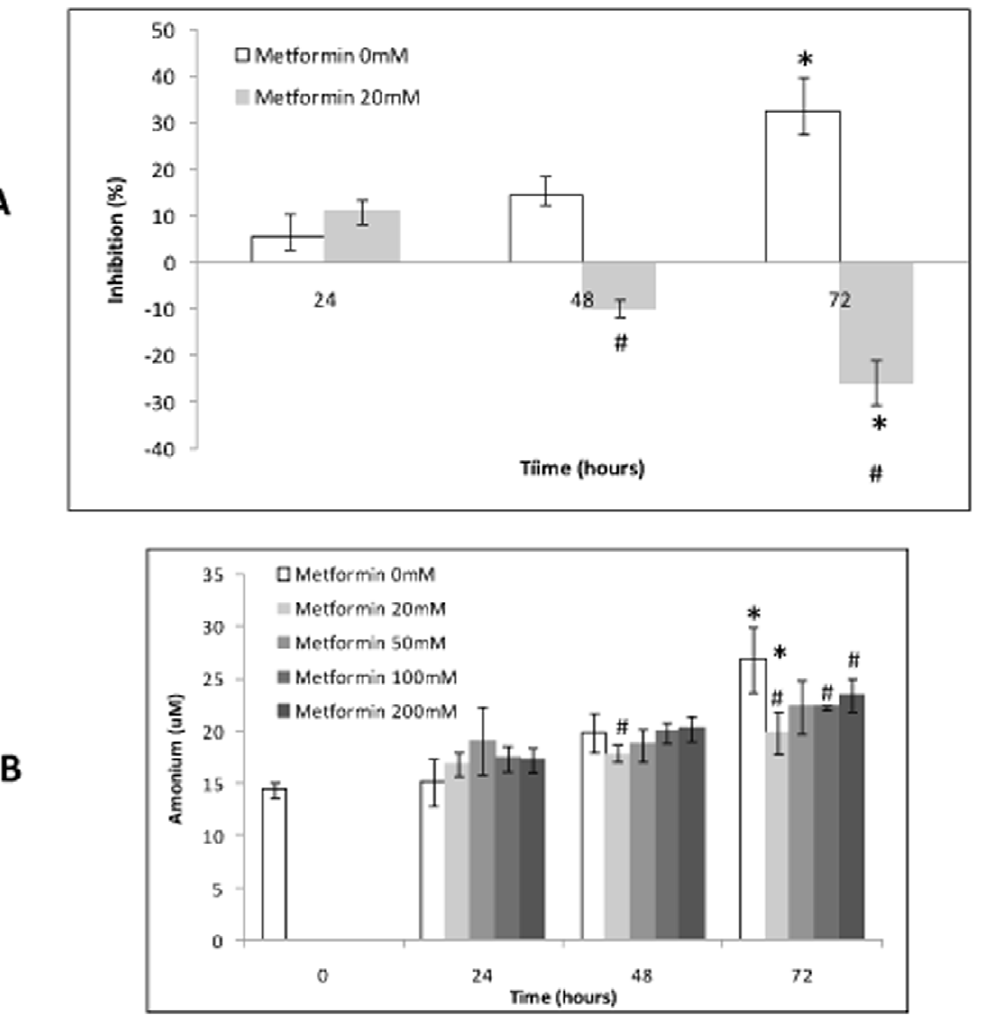
Figure 3. Effect of metformin on glutaminase activity invitro. 3A) Glutaminase activity inhibition in cells assay (%), according to metformin concentration; 3B) Ammonia concentration in cells assay, according to metformin concentration. Each bar represents the mean 6 SD (all experiments were conducted by triplicate). *p # 0.05 vs. the corresponding control sample. # p # 0.05 vs. the same group collected at the previous time point.